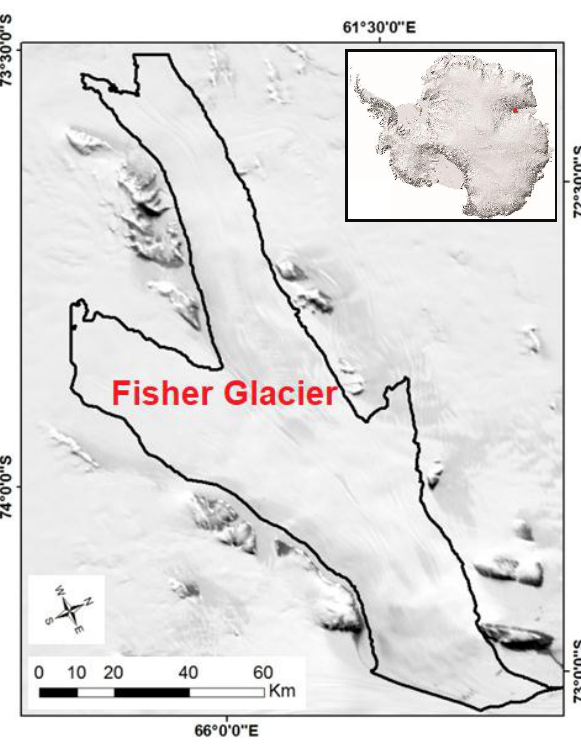
Figure 1: Geographical location of the study area.